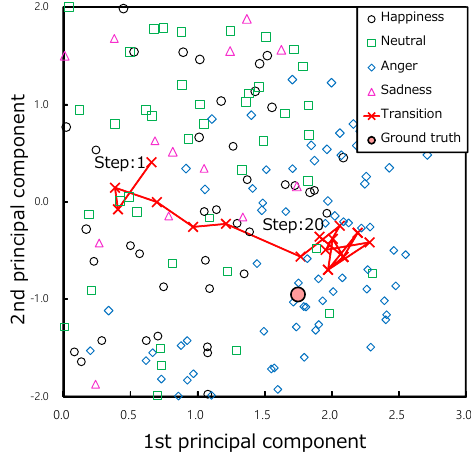
Figure 9: Example trajectory of the estimation in the PC1-2 space through the mental simulation under the Han.-Aud condition.